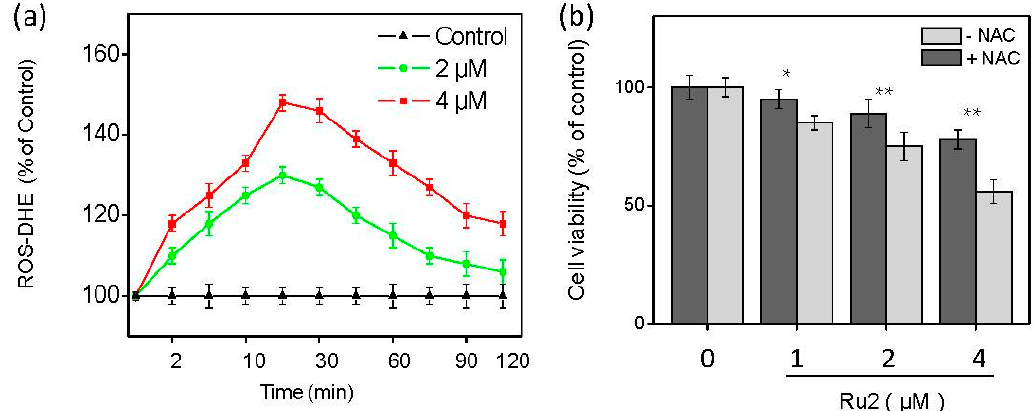
Figure 7. Important roles of ROS in cell apoptosis induced by Ru2. ( a ) Effects of concentration on intracellular ROS generation following Ru2 treatment in HepG2 cells. The cells were treated with 10 μ M DHE probe for 30 min; ( b ) Protective effects of N -acetylcysteine (NAC) on Ru2 -induced growth inhibition. Bars with different characters are statistically different at * p < 0.05 and ** p < 0.01 levels. The cells were pretreated with NAC (1 mM) for 2 h followed by co-incubation with different concentrations of Ru2 .